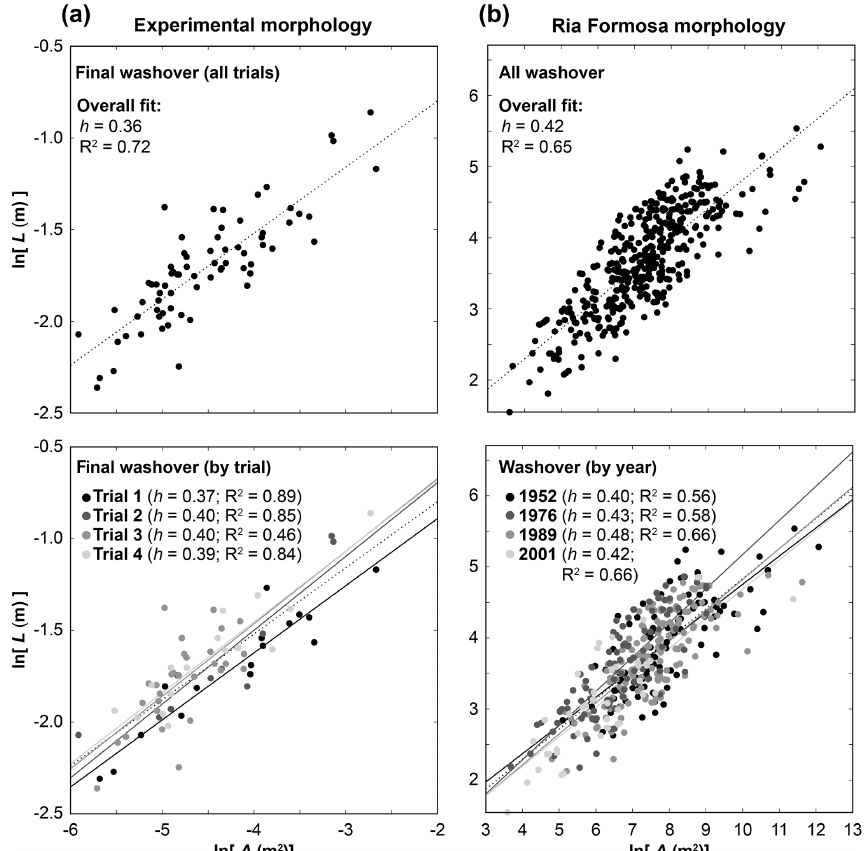
Figure 2. Log-transform comparison of length-to-area relationships in (a) final steady-state experimental washover morphology, measured from overhead imagery of the experimental tank and (b) washovers along the Rio Formosa barriers of southern Portugal, measured from four sets of aerial images (taken in 1952, 1976, 1989, and 2001), detailed in Matias et al. (2008). Upper plots in (a) and (b) show all the data points, fitted with a power relationship. Lower plots in (a) and (b) differentiate the data according to experimental trial in (a) and image year in (b) , each fitted with its own power relationship (along with the ensemble fits from the upper plots), demonstrating that no single trial or image year dominates the overall pattern of the data – nor does any single barrier or barrier aspect in the Ria Formosa data (see Fig. S1). Note that the negative values for the experimental washover shown in (a) are the result of the log transformation. Experimental and Ria Formosa data are shown in the same plot in Fig.